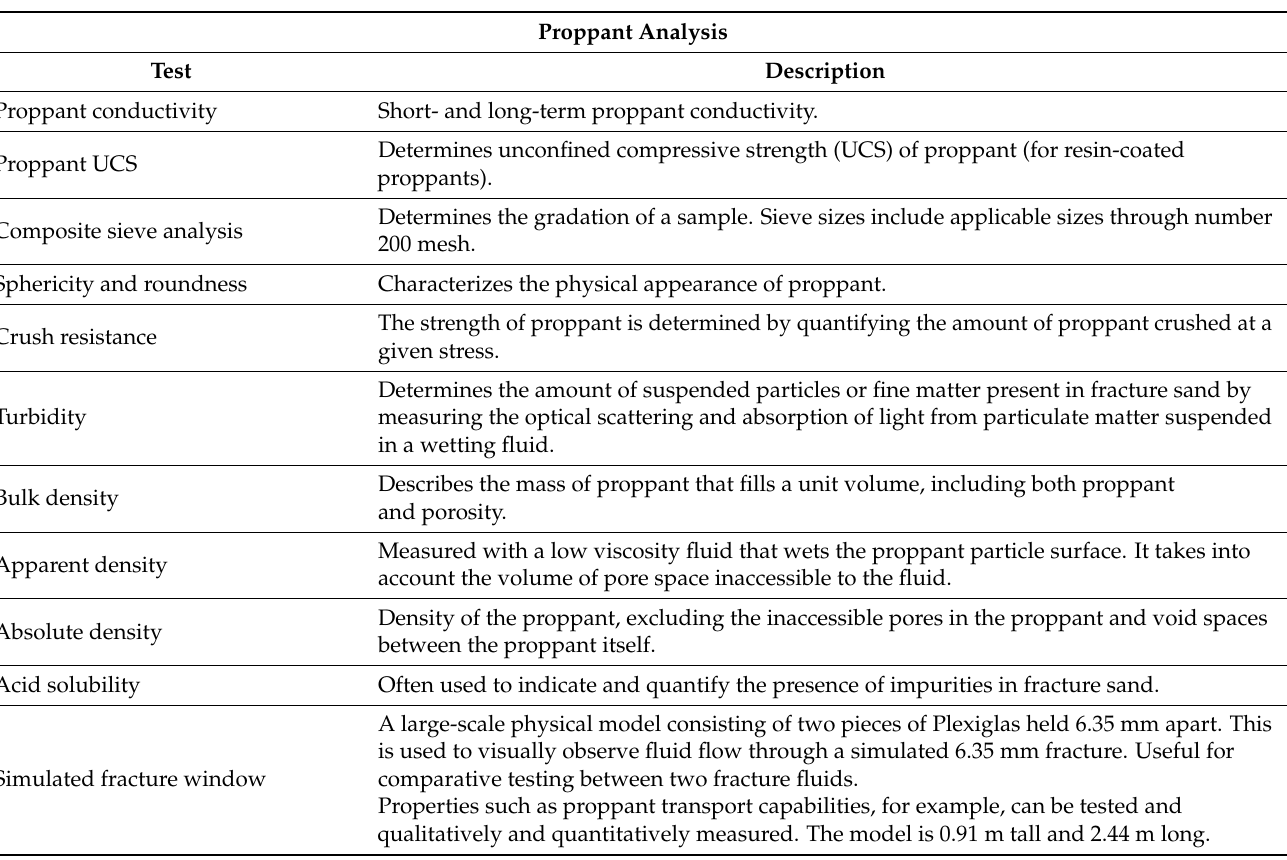
Table 3. Proppant